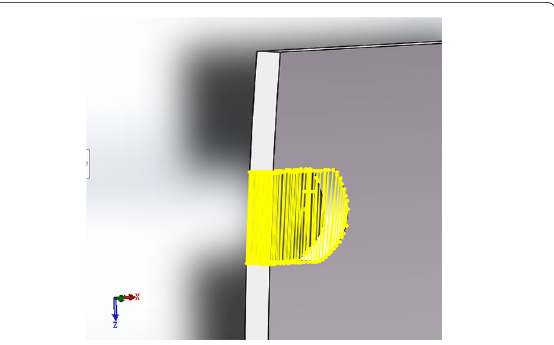
Figure 22 Machining path generated by iso-parametric tool-path planning